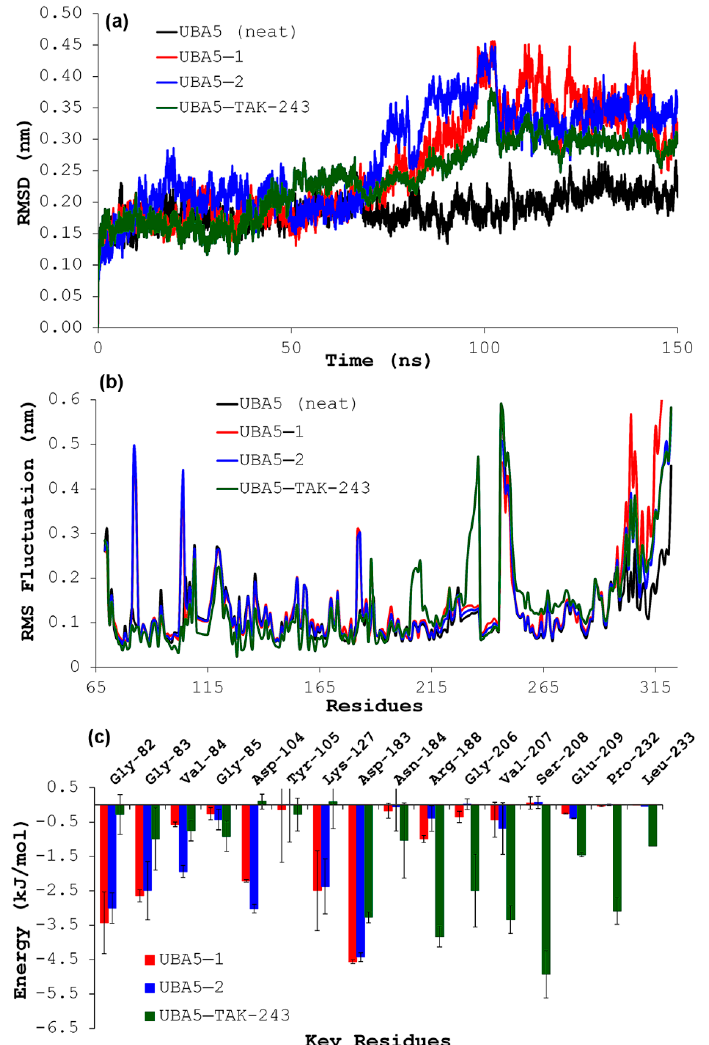
Figure 3. Results after molecular dynamics simulations on the interaction of test alkaloids 1 – 2 and inhibitor TAK-243 with UBA5. ( a ) C α root-mean-square deviation (RMSD) values (nm) over the simulation time (150 ns) of UBA5 (neat) (black) and complexes UBA5 ─ 1 (red), UBA5 ─ 2 (blue), and UBA5 ─ TAK-243 (green). ( b ) RMS fluctuations of the backbone atoms of UBA5 (black) and complexes UBA5 ─ 1 (red), UBA5 ─ 2 (blue), and UBA5 ─ TAK-243 (green). ( c ) Molecular mechanic / Poisson-Boltzmann surface area (MM / PBSA) per-residue decomposition energies for selected residues of complexes UBA5— 1 (red), UBA5— 2 (blue), and UBA5—TAK-243 (green) after simulation using the last 50